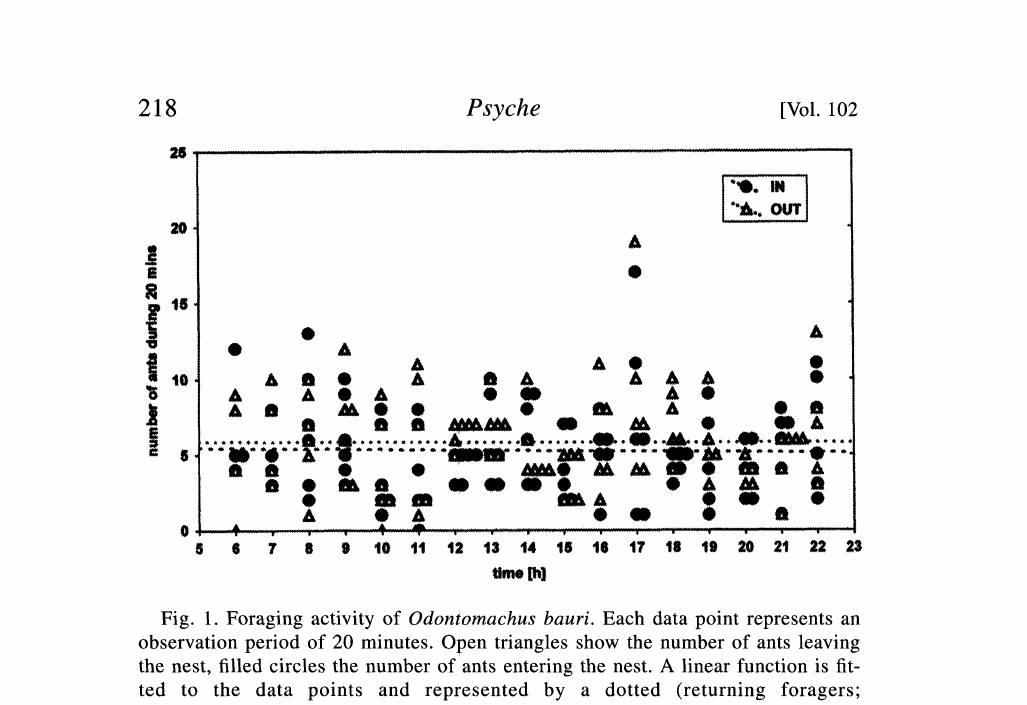
Fig. 1. Foraging activity of Odontomachus bauri. Each data point represents an observation period of 20 minutes. Open triangles show the number of ants leaving the nest, filled circles the number of ants entering the nest. A linear function is fit- ted to the data points and represented by a dotted (returning foragers; y=5.55-0.018x; p=0.78) or dashed (leaving foragers; y=5.84-0.001x; p-0.98) line. Data were collected from the obSeryation of six colonies (except 6h,7h n=4; 19h n=5). The bar indicates the light/dark period.